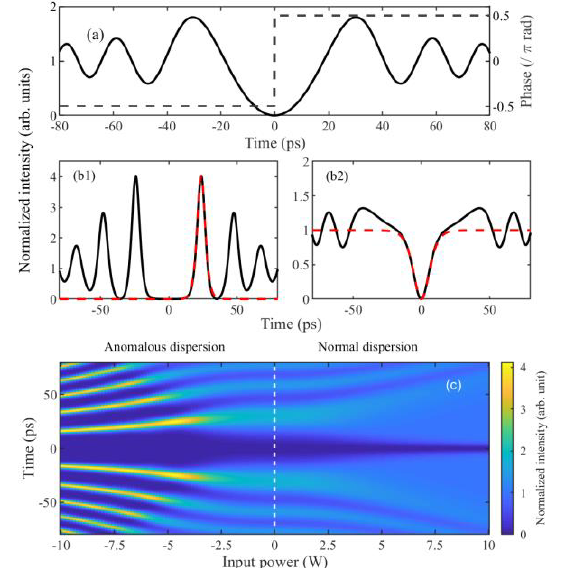
Fig. 1. (a) Initial phase jump (dashed line) and output intensity profile without nonlinearity. (b) Details of the impact of nonlinearity in the anomalous and normal dispersion (b1 and b2). Red dashed lines are fits by a bright and a black soliton. (c) Influence of the initial average power on the output